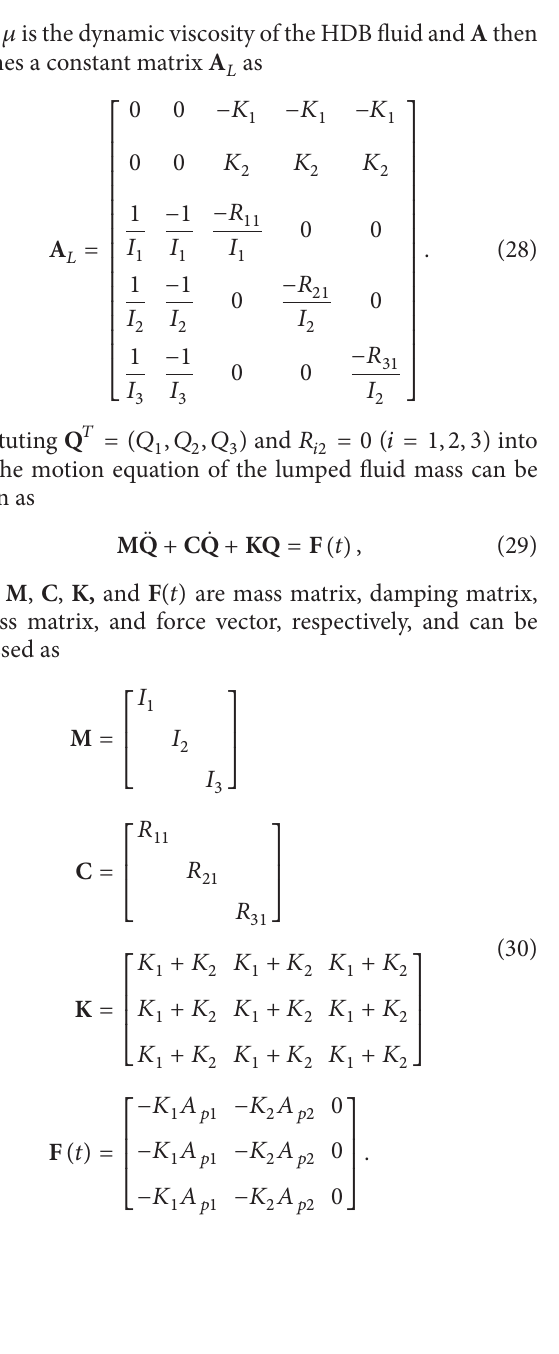
Figure 9: Fluid system model of hydraulic bushing with multiple identical inertia tracks and identical